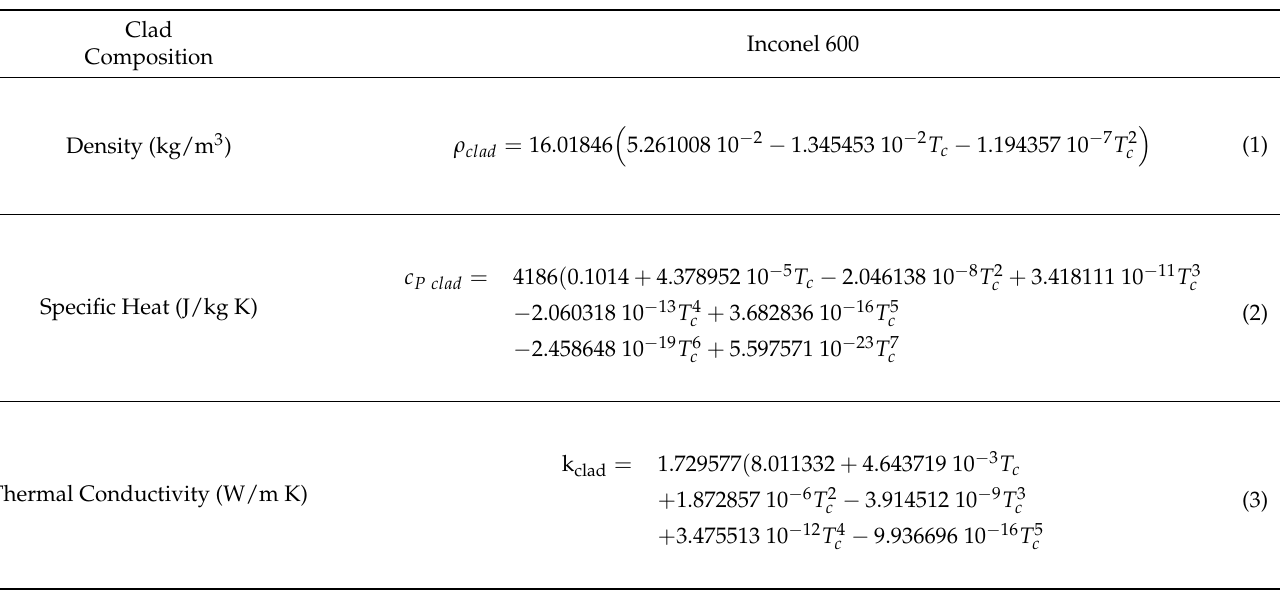
Table 2. 1 × 1 and 5 × 5 materials from the PSBT benchmark.